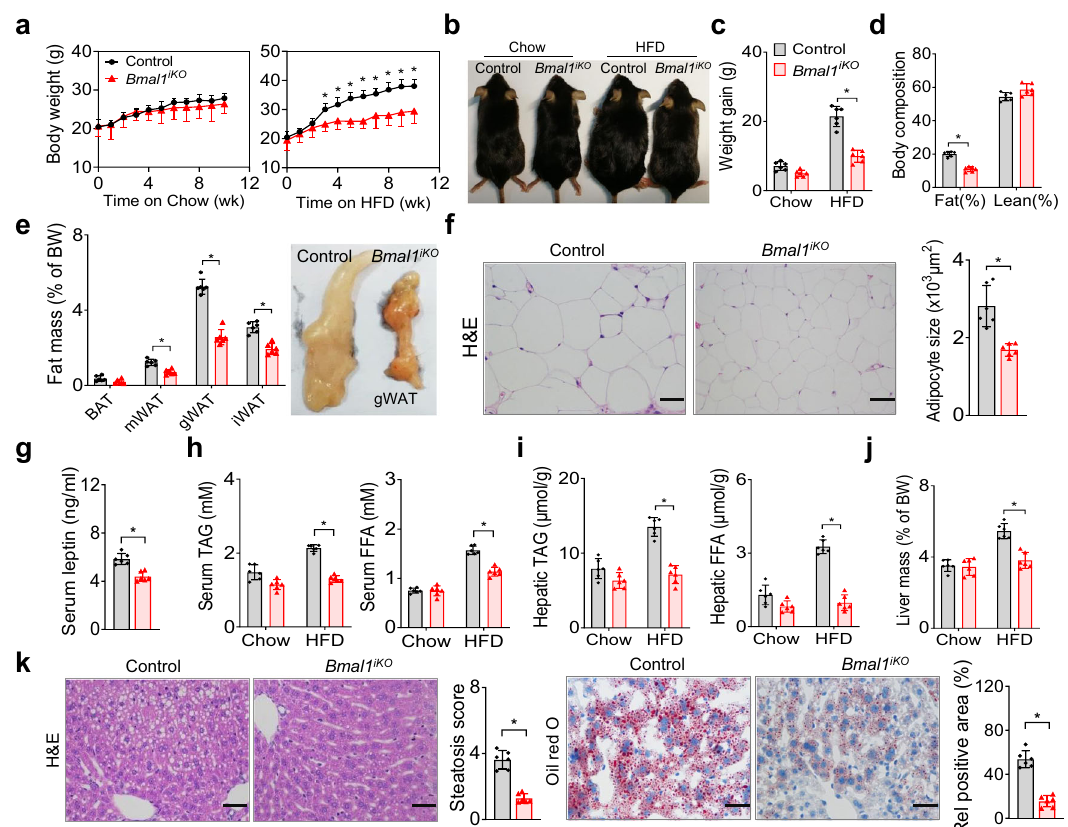
Fig. 1 De fi ciency of intestinal Bmal1 protects mice from HFD-induced obesity. a Body weight curves of Bmal1 iKO and control mice fed on a chow diet or HFD. b Representative images of Bmal1 iKO and control mice fed on chow diet or HFD for 10 weeks. c Body weight gain of Bmal1 iKO and control mice fed on chow diet or HFD for 10 weeks. Two-sided t test p values: 0.0501 (chow) and 0.0004 (HFD). d Body composition of Bmal1 iKO and control mice fed on HFD for 10 weeks. Two-sided t test p values: 0.0004 (Fat) and 0.0504 (Lean). e Fat percentages of Bmal1 iKO and control mice fed on HFD for 10 weeks.